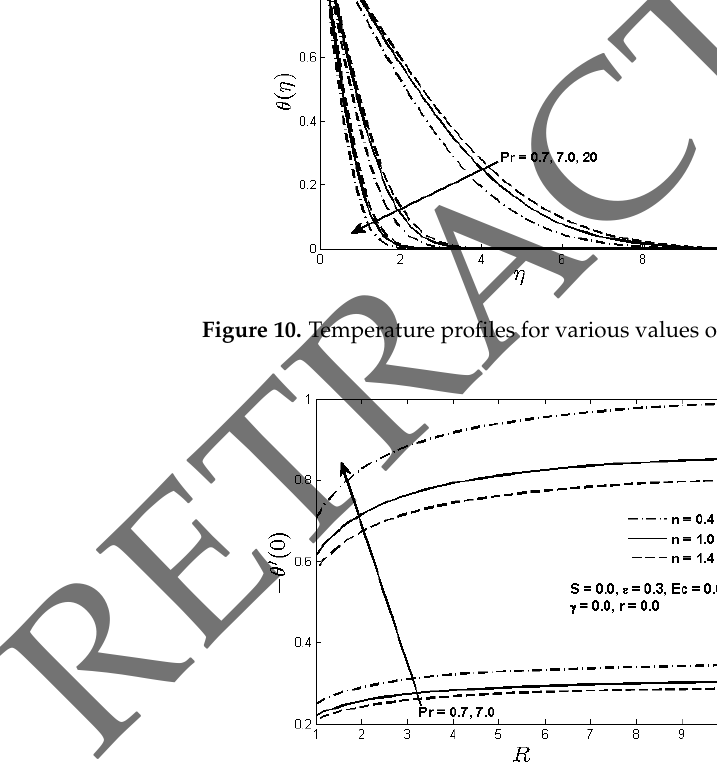
Figure 11. − θ (cid:48) ( 0 ) vs. R for various values of Pr and n